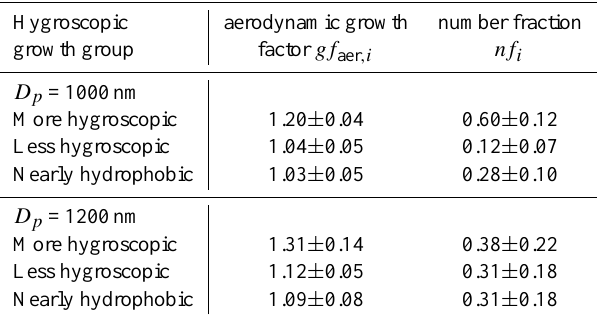
Table 3. Mean hygroscopic diameter growth factors, number frac- tions and standard mean deviation for coarse particles with D p of 1.0 and